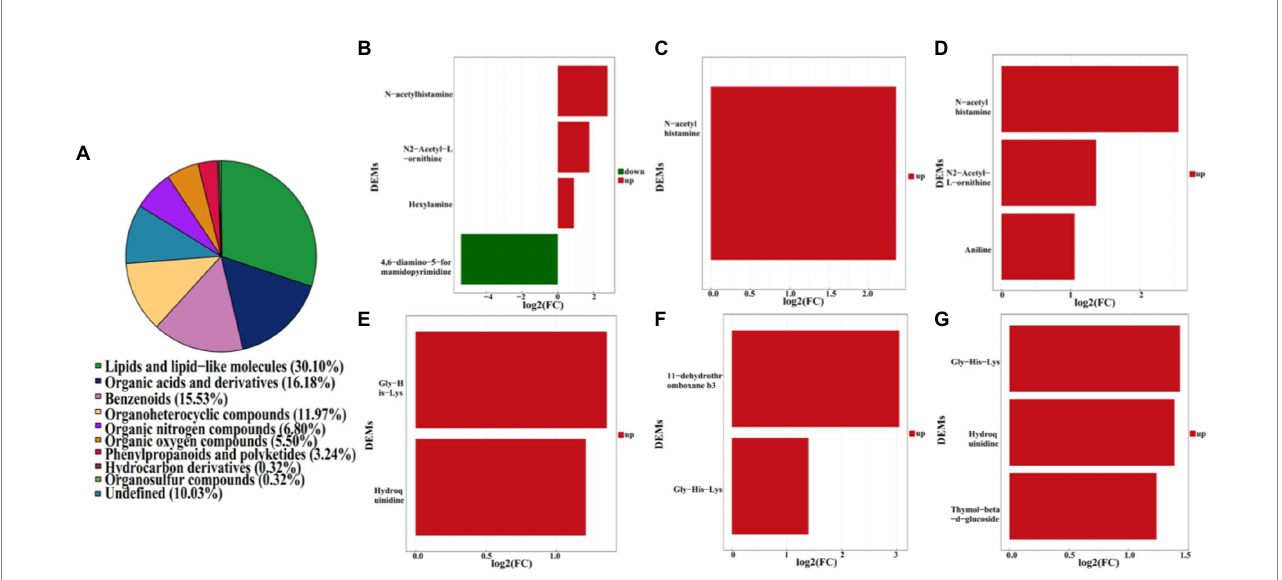
FIGURE 7 Metabolite classification statistics (A) , and DEMs in different treatment groups. (B,E) MF-HZ23 vs. the control; (C,F) MF-HZ23 plus CCF vs. the control; (D,G) CCF vs. the control. Red and green represents upregulated and downregulated, respectively.